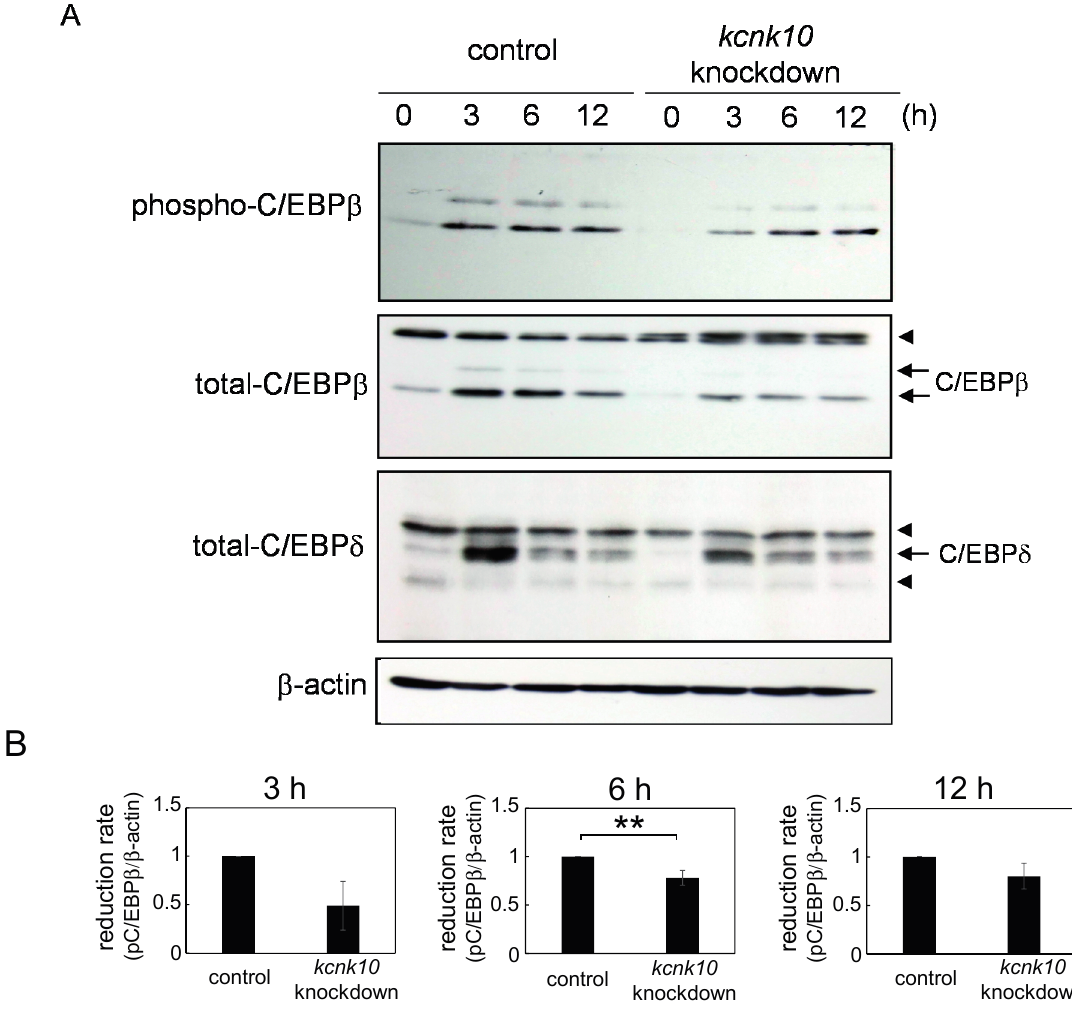
Figure 3. Effect of kcnk10 knockdown on the phosphorylation and protein levels of C/EBP β , and the protein level of C/EBP δ . At 72 h after transfection, post-confluent kcnk10 knockdown cells or control cells were induced to differentiate into adipocytes. Whole-cell lysates were prepared from the cells at various time points after induction and were subjected to Western blot analyses. β -actin was used as a loading control. ( A ) These figures show typical results. Arrowheads show nonspecific bands; ( B ) Quantitation of reduction rate of phospho-C/EBP β after induction; ( C ) Quantitation of reduction rate of total-C/EBP β after induction; and ( D ) Quantitation of reduction rate of C/EBP δ after induction. The asterisks indicate significant differences compared with the values for control cells ( ** p < 0.05). All immunoblots obtained from 3 different lots were shown in Supplementary Figures